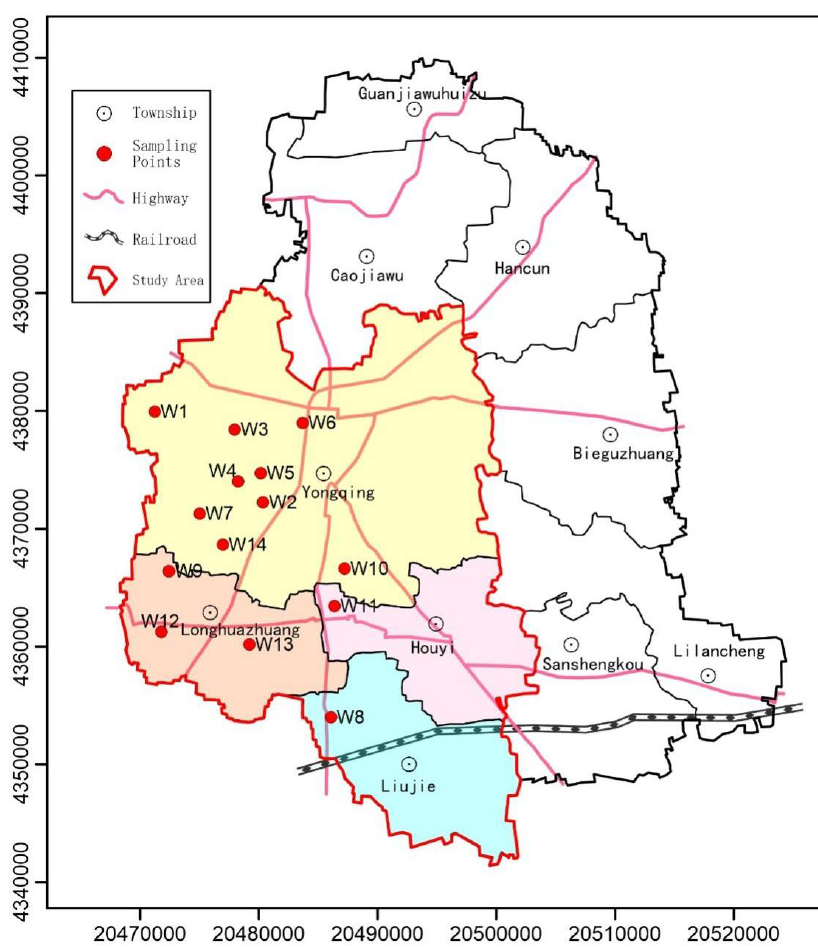
Figure 2. Spatial distribution of sampling points in the study area.